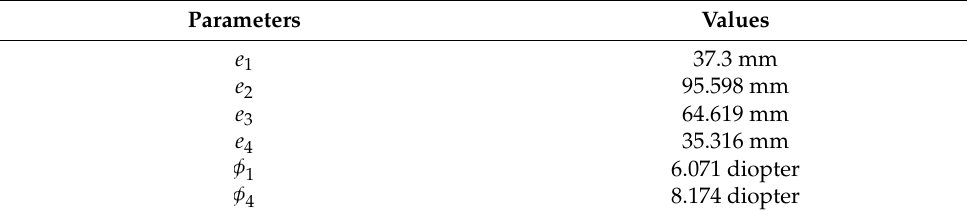
Table 3. Solving result for structural parameters.